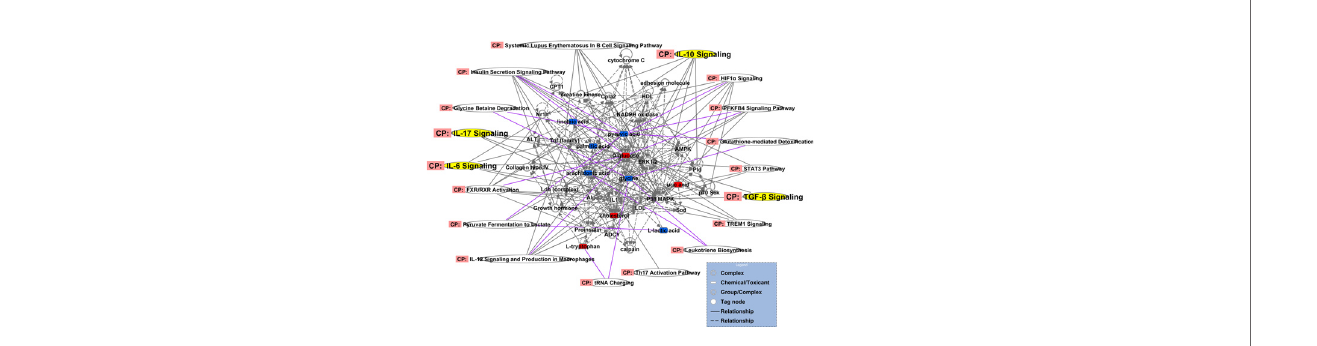
FIGURE 10 | Differential expression network of plasma metabolites in gingivitis patients. The metabolites, which are marked in red, indicating signi fi cantly increased in gingivitis group. The blue marked metabolite indicates